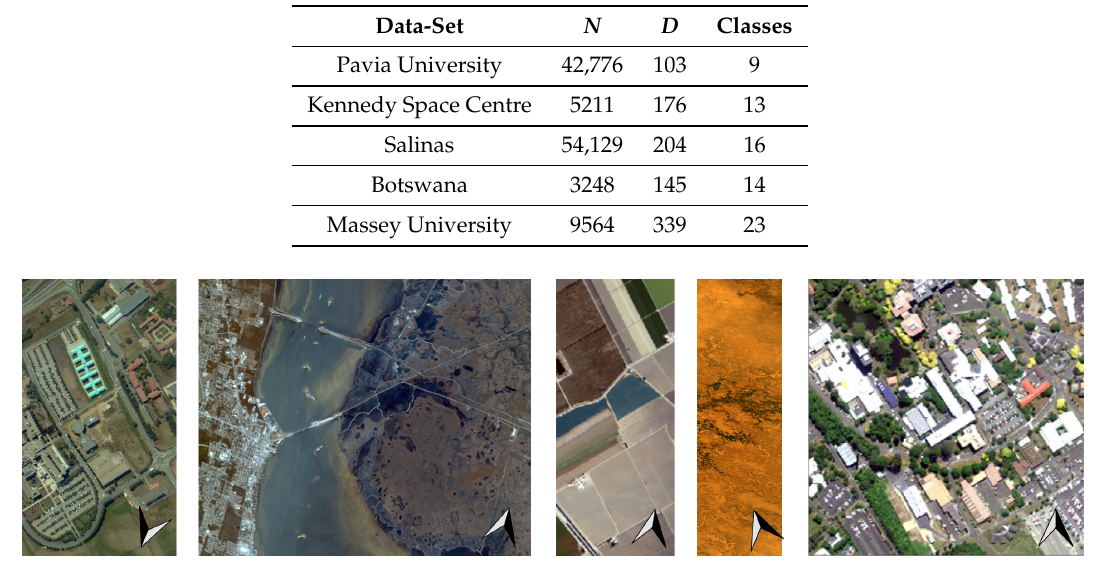
Figure 4. Colour composites (re-scaled and contrast-enhanced for visualisation) for the five scenes used in this study: (from left to right) Pavia University, Kennedy Space Centre, Salinas, Botswana and Massey University scenes. The arrow at the bottom right of each scene indicates the North